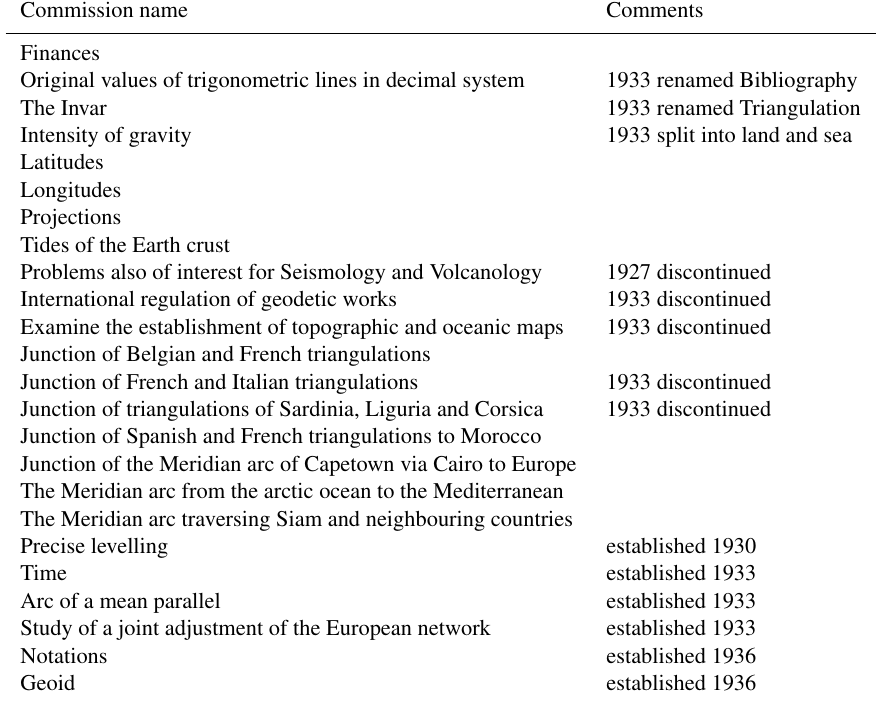
Table 1. Commissions active in the period from 1924 to